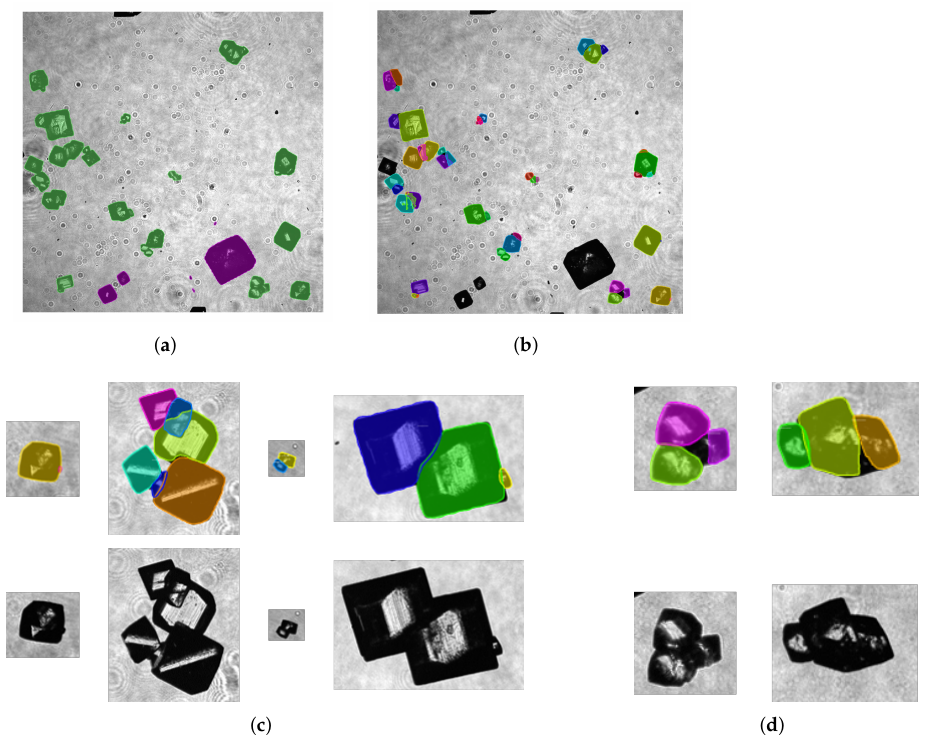
Figure 7. Visualization of the three-class task using M3_2PP. ( a ) Single crystals (purple) and agglom- erates (green) detected from Figure 1, ( b ) Primary crystals in agglomerates (random color for each) detected from Figure 1, ( c ) Exemplary agglomerates: Selected segmented agglomerates (random color for each primary crystal in agglomerate) at the top and the corresponding cropped original agglomerates at the bottom, ( d ) Insufficiently detected contours of primary crystals in agglomerates.